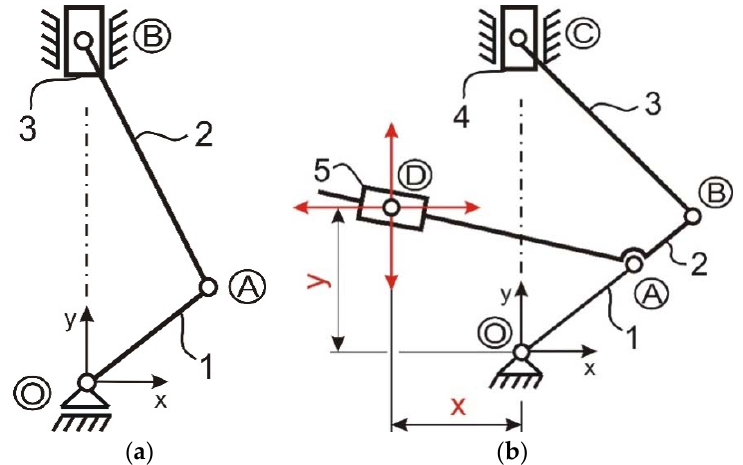
Figure 2. Kinematic schema for two concept of engine mechanism: ( a ) classic; ( b ) with oscillating arm.